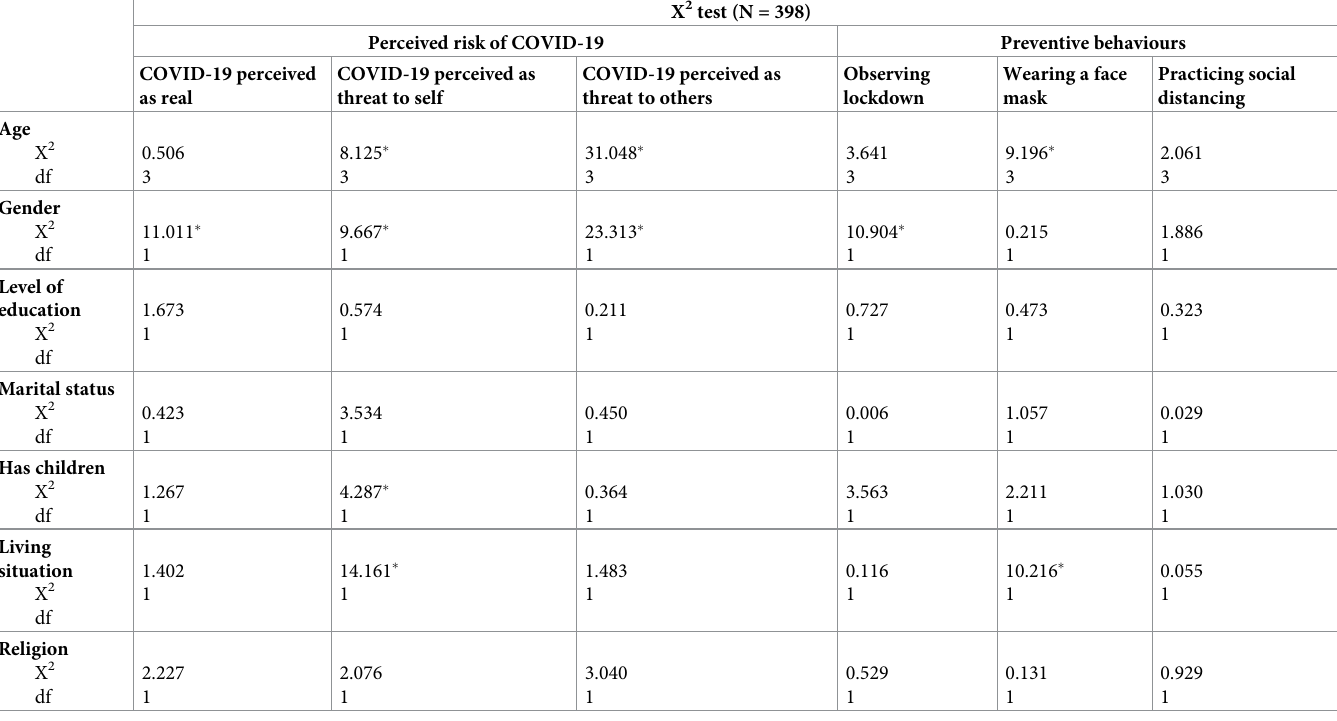
Table 3. Associations between students’ sociodemographic characteristics and COVID-19 perceptions and preventive behaviours.